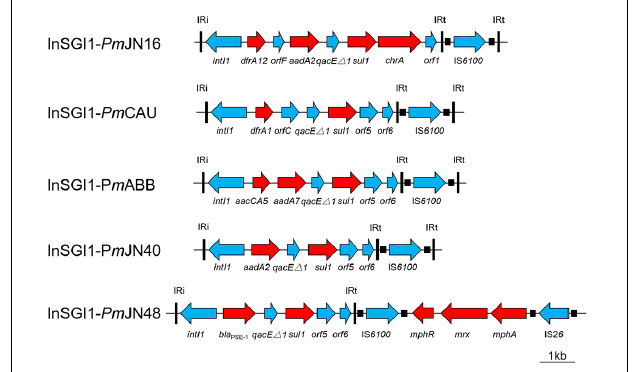
FIGURE 2 | Schematic view of the MDR region within the SGI1 of P. mirabilis . Antibiotic resistance genes are indicated by red arrows. Thin vertical bars represent the inverted repeats of class I integron (IRi/IRt). Small filled squares represent the inverted repeats of the IS.